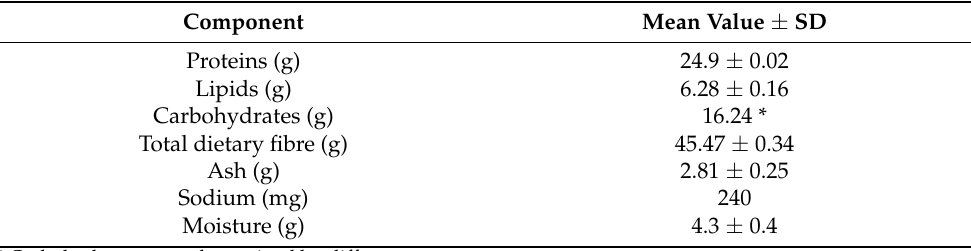
Table 4. BSG flour composition per 100 g.